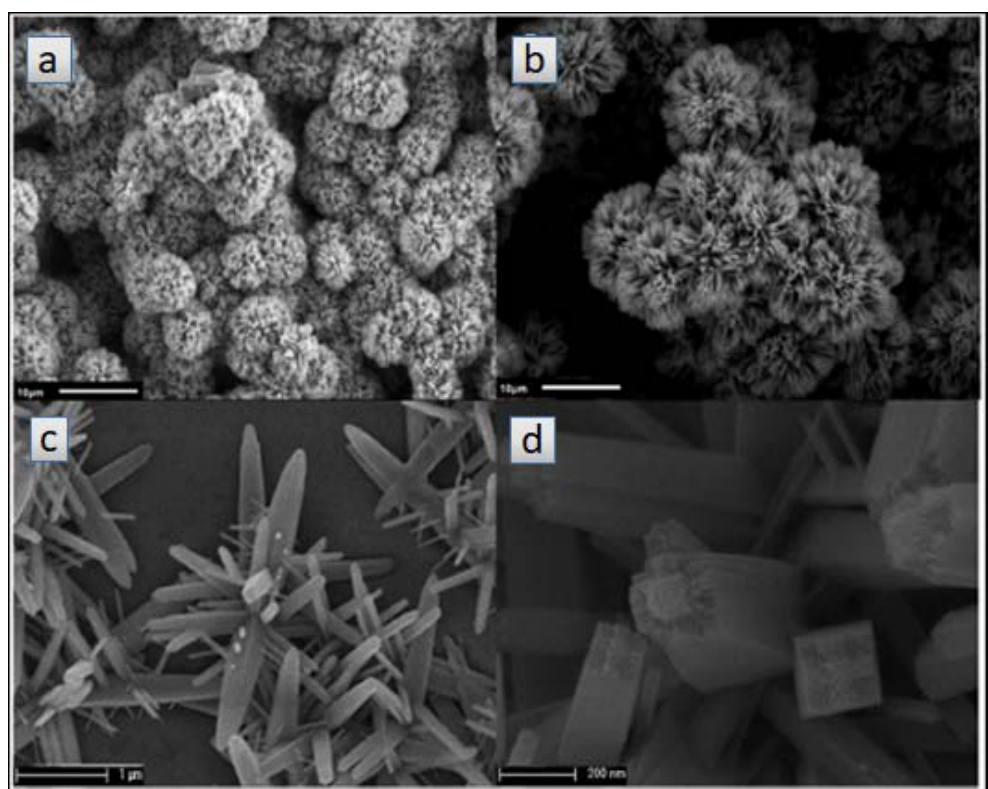
Figure 15. SEM images of the TiO 2 NWs at different magnifications: 2500× ( a ). 5000× ( b ), 33,000× ( c ), and 50,000× ( d ). Reproduced with permission from reference [131].